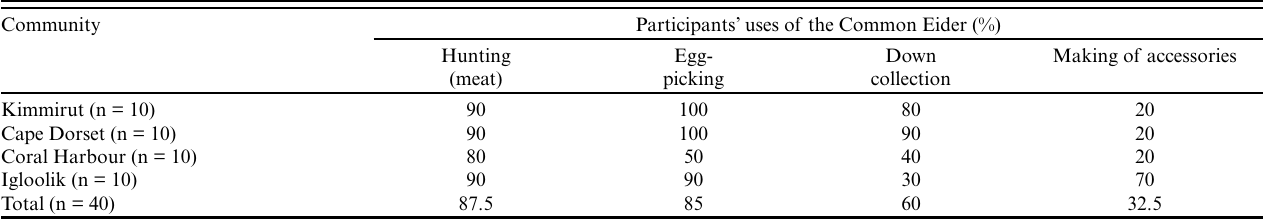
Table 2 . Participants’ uses of the Common Eider ( Somateria mollissima ) presented by community and types of uses. Community Participants’ uses of the Common Eider (%)